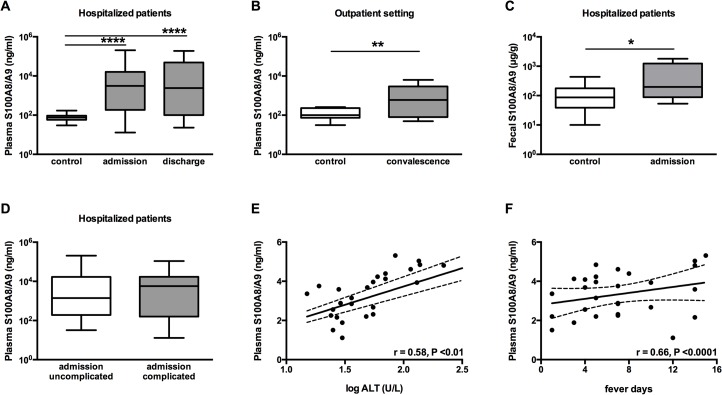
S100A8/A9 complexes are abundantly present in plasma and feces from patients with typhoid fever and correlate with duration of fever.Increased levels of S100A8/A9 (ng/ml) complexes are measured in plasma of patients with confirmed typhoid fever caused by S. Typhi admitted to the hospital (A; n = 28 for admission) and compared to healthy controls (n = 38). However S100A8/A9 levels were not yet normalized at time of discharge (n = 15). In a community based control study during convalescence (3 weeks post infection) S100A8/A9 remains elevated (B; n = 60) compared to healthy controls (n = 60). Increased levels of S100A8/A9 (μg/g) measured in feces from hospitalized patients (C; n = 14) compared to healthy controls (n = 36). No differences were seen in levels of S100A8/A9 between hospitalized patients with complicated or uncomplicated typhoid fever as detailed in method section (D). Data are expressed as box-and-whisker diagrams depicting the smallest observation, lower quartile, median, upper quartile and largest observation. Correlation curve log alanine aminotransferase (ALT) versus log plasma S100A8/A9 (E). Correlation curve days of fever prior to admission versus log plasma S100A8/A9 (F). For linear regression analysis, P value and Spearman rho are reported.